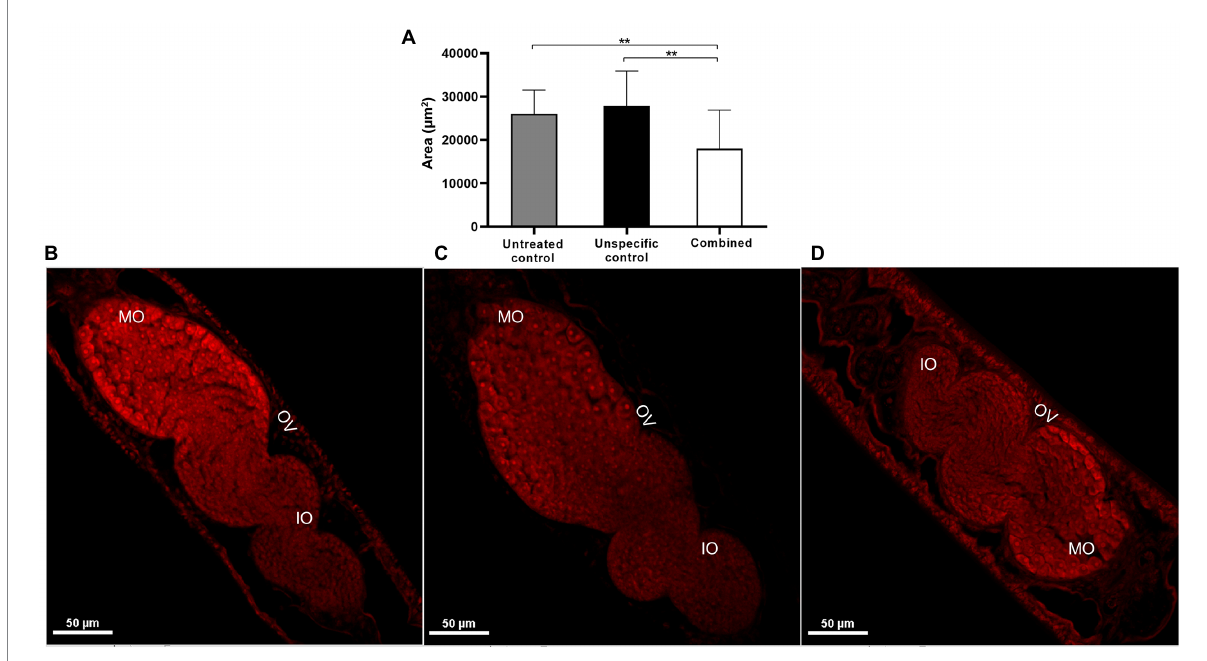
FIGURE 10 Phenotypic changes in female adult worms recovered from mice infected with SmHGPRTases knocked-down schistosomula. (A) Bars representing the ovary area of female adult worms from the untreated control (gray), unspecific control (black), and combined SmHGPRTases group (white). Above the bars are represented the standard error of the mean of three replicates. After verifying the normality using the Shapiro– Wilk test, significant differences compared to controls were analyzed by unpaired t -test (** p ≤ 0.01). (B–D) Representative confocal images demonstrating female adult worms recovered from the untreated control (B) , unspecific control (C) , and the combined SmHGPRTases group (D) . MO, mature oocyte; IO, immature oocyte; OV, ovary. Scale bars: 50 μ